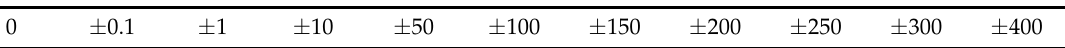
Table 2. Calibration angular rate point ( ◦